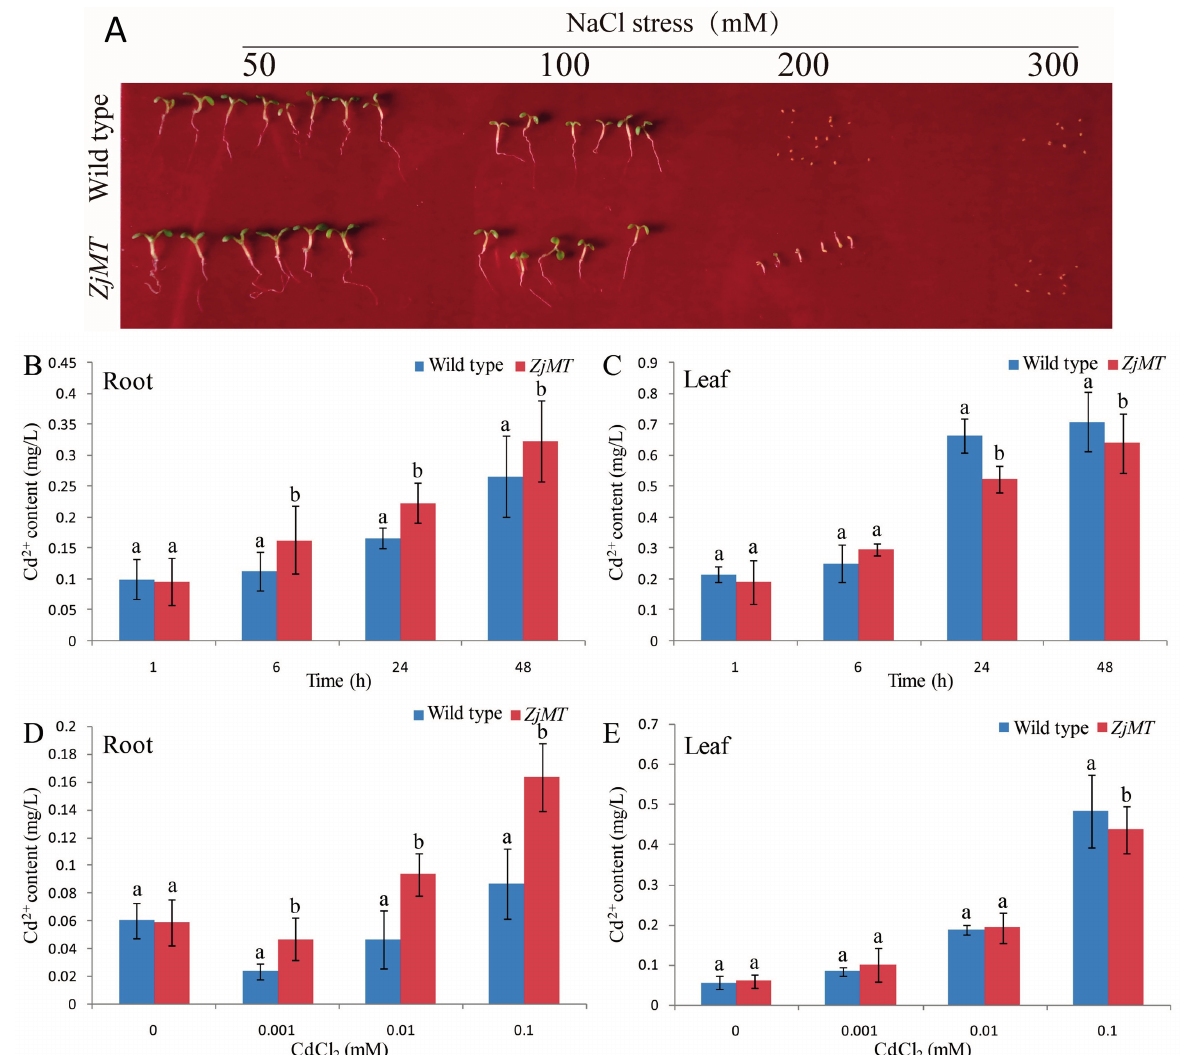
Figure 4. High salinity assays of ZjMT transgenic plants and the concentrations of Cd 2+ in roots and leaves of wild type and transgenic Arabidopsis plants. ( A ) Phenotypic comparison of root lengths. Wild type and transgenic seeds were germinated and grown on MS medium with 50, 100, 200 or 300 mM NaCl for 7 days. The concentrations of Cd 2+ in the roots ( B ) and leaves ( C ) of wild type and transgenic plants exposed to 0.1 mM CdCl 2 with indicated time points. Cd 2+ content in the roots ( D ) and leaves ( E ) of wild type and transgenic plants treated with various concentrations of CdCl 2 for 24 h. Different letters in ( B – E ) indicate statistically significant differences between means at p < 0.05 (Student’s t